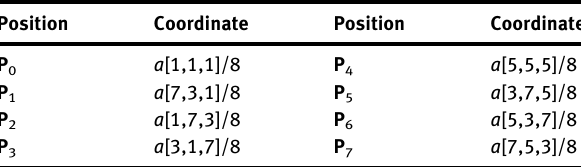
Table  : Positions of balls in single gyroid in Figure  e.